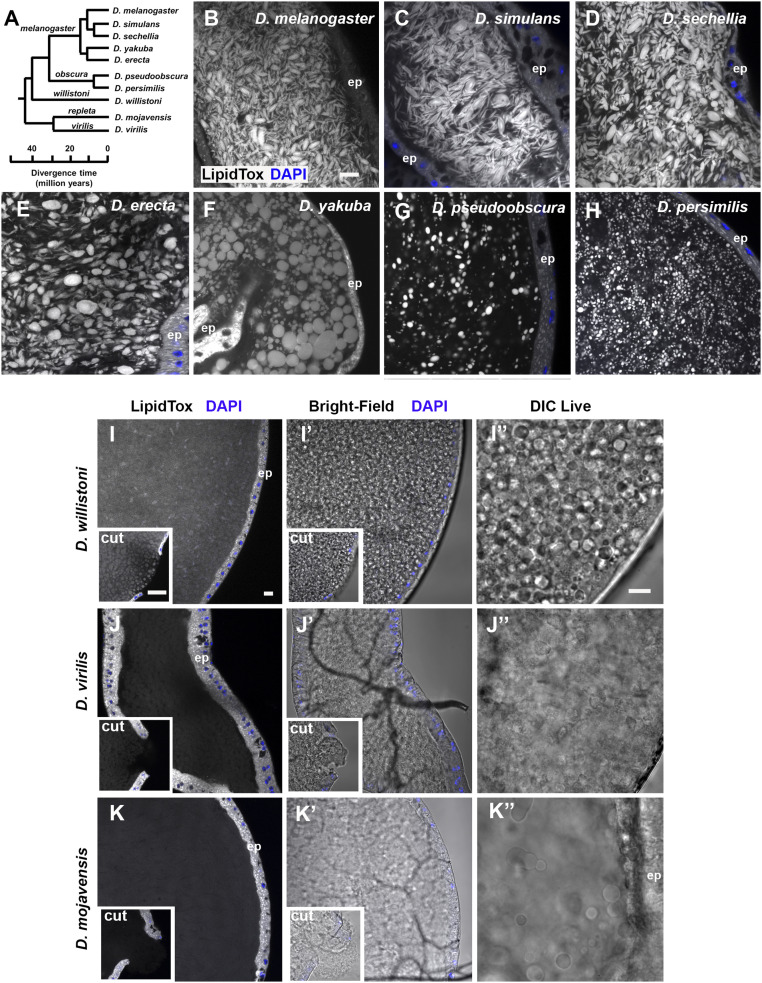
Coevolution of microcarrier morphology and SP in Drosophila species. (A) Phylogenetic tree of Drosophila species used in this study. All species except D. mojavensis have a putative SP homolog. Adapted from flybase.org/blast/. (B–K) LipidTox staining of AGs from 6-d-old virgin males from selected Drosophila species, namely D. melanogaster (B), D. simulans (C), D. sechellia (D), D. erecta (E), D. yakuba (F), D. pseudoobscura (G), D. persimilis (H), D. willistoni (I), D. virilis (J), and D. mojavensis (K). For (I–K), where LipidTox microcarriers are not readily detectable, bright-field images of the same glands are shown (I′–K′), as well as DIC images (I′′–K′′) of different glands. Insets in I–K) are images of AG with epithelial layer punctured to fully expose luminal contents to LipidTox stain, revealing stained structures only in D. willistoni. Note that different subgroups have noticeably different microcarrier size, shape, and density. Nuclei marked with DAPI (blue). AG epithelium (ep). (All scale bars: 10 µm; scale bar in B applies to B–H; scale bar in I, applies to I–K and I′–K′; and scale bar in I′′ applies to I′′–K′′.)